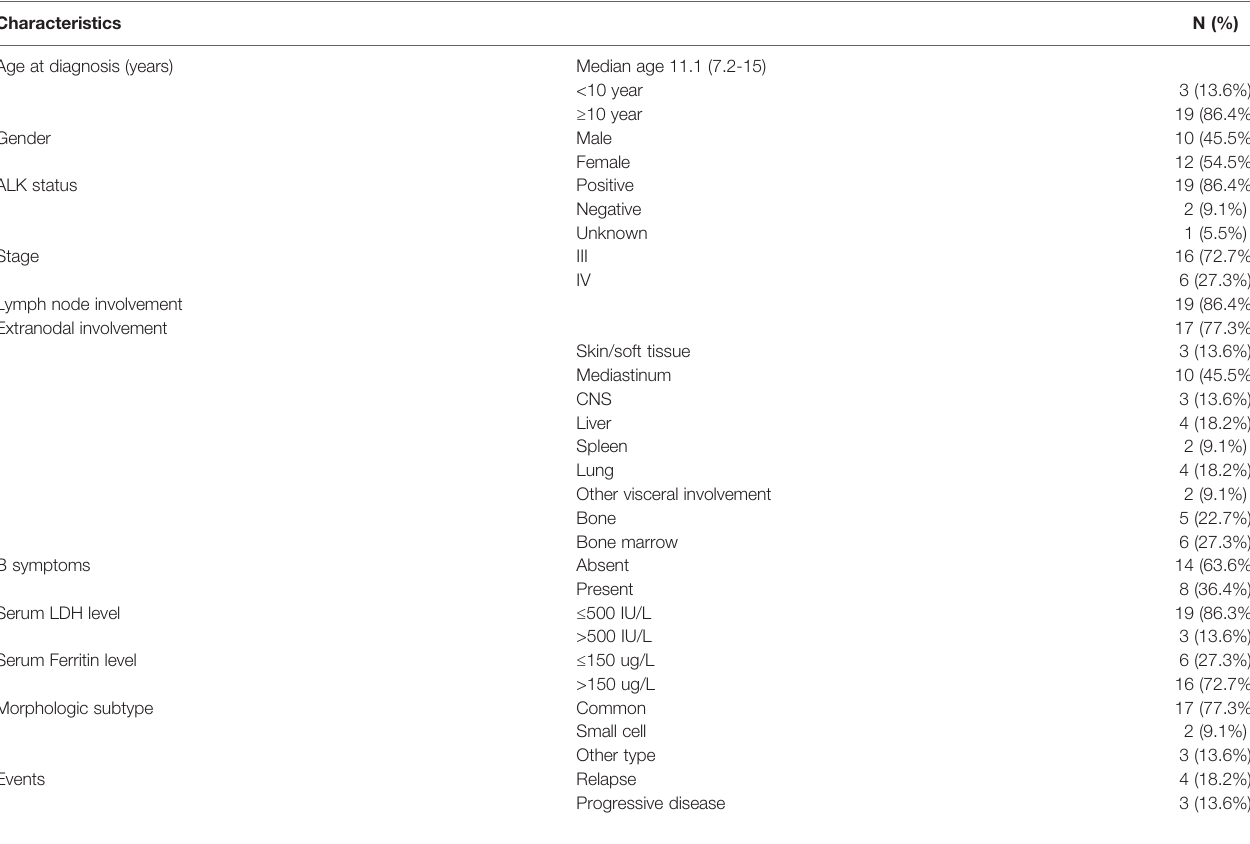
TABLE 1 | Demographic and clinical characteristics of 21 children with advanced stage